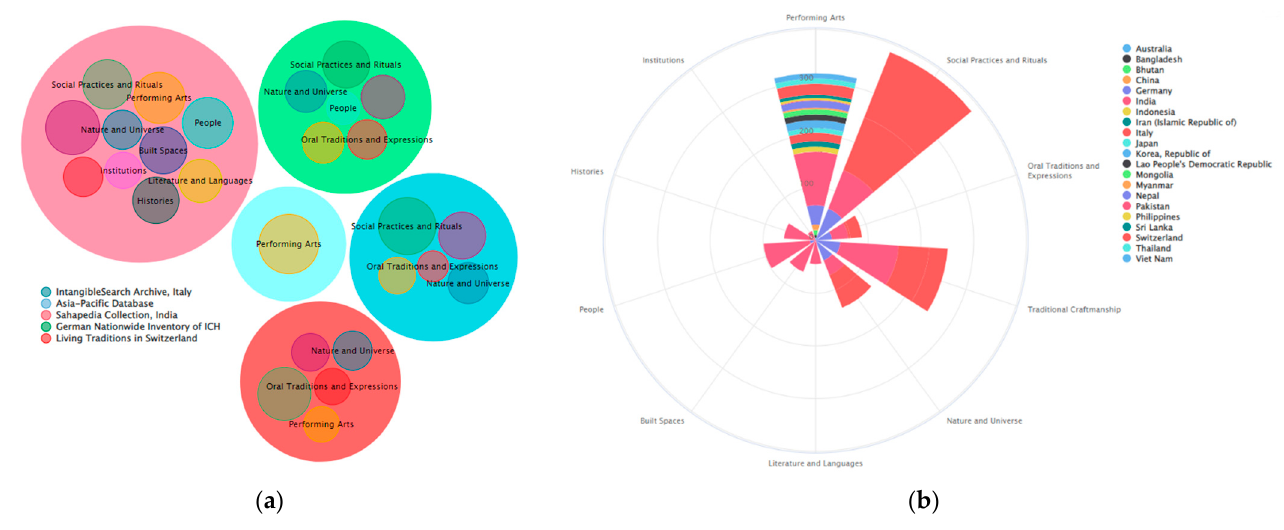
Figure 15. All ICH items displayed: ( a ) bubble graph; ( b ) wind rose graph.